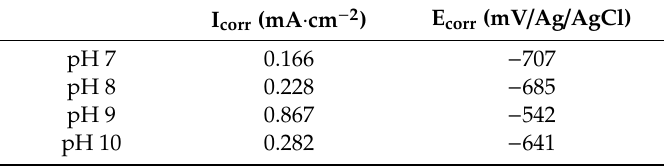
Figure 9. Potentiodynamic polarization curve of working electrode in di ff erent pH environments. Table 2. Corrosion density and potential of working electrode in di ff erent pH